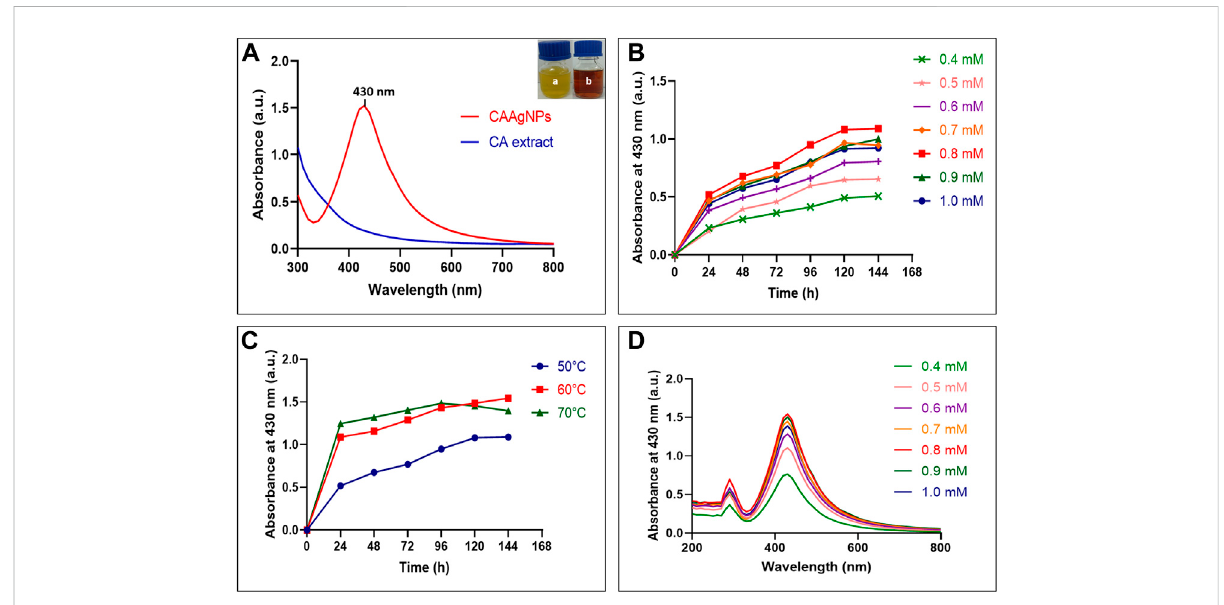
FIGURE 1 Optimization of CAAgNPs synthesis (A) UV-visible spectrum for aqueous CA rhizome extract and synthesized CAAgNPs (maximum peak at 430 nm). “ a ” in the inset indicates yellow colored aqueous CA rhizome extract before synthesis and “ b ” indicates brown colored CAAgNPs after synthesis. Time course of CAAgNPs synthesis at (B) 0.4, 0.5, 0.6, 0.7, 0.8, 0.9, and 1 mM concentration of AgNO 3 , and (C) 50, 60, and 70 ° C temperatures. (D) UV-visible spectrum for CAAgNPs synthesis using range of concentrations of AgNO 3 at 144